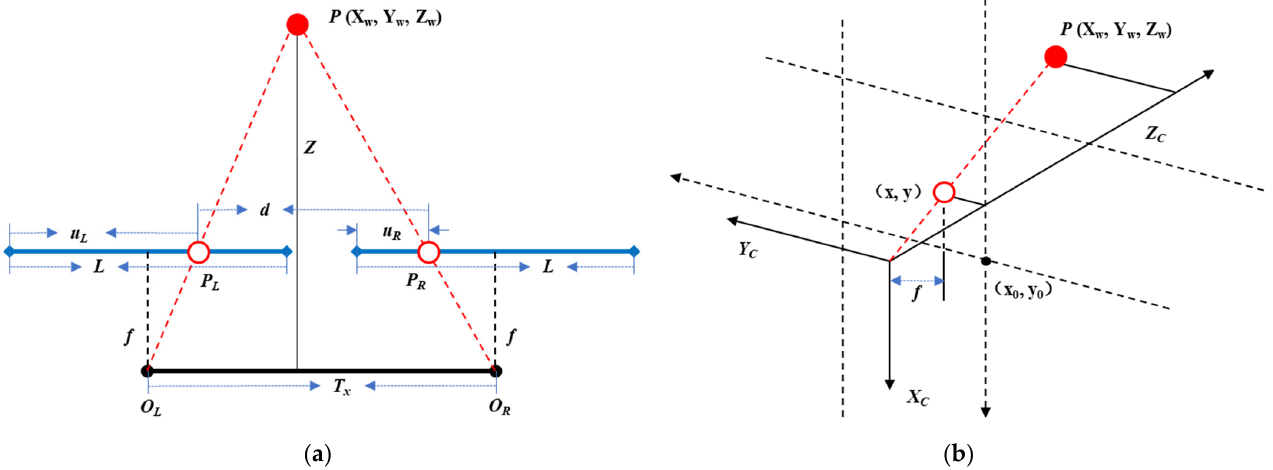
Figure 4. Principle of the binocular stereo imaging parallax. ( a ) Schematic of depth information; ( b ) schematic of XY information.